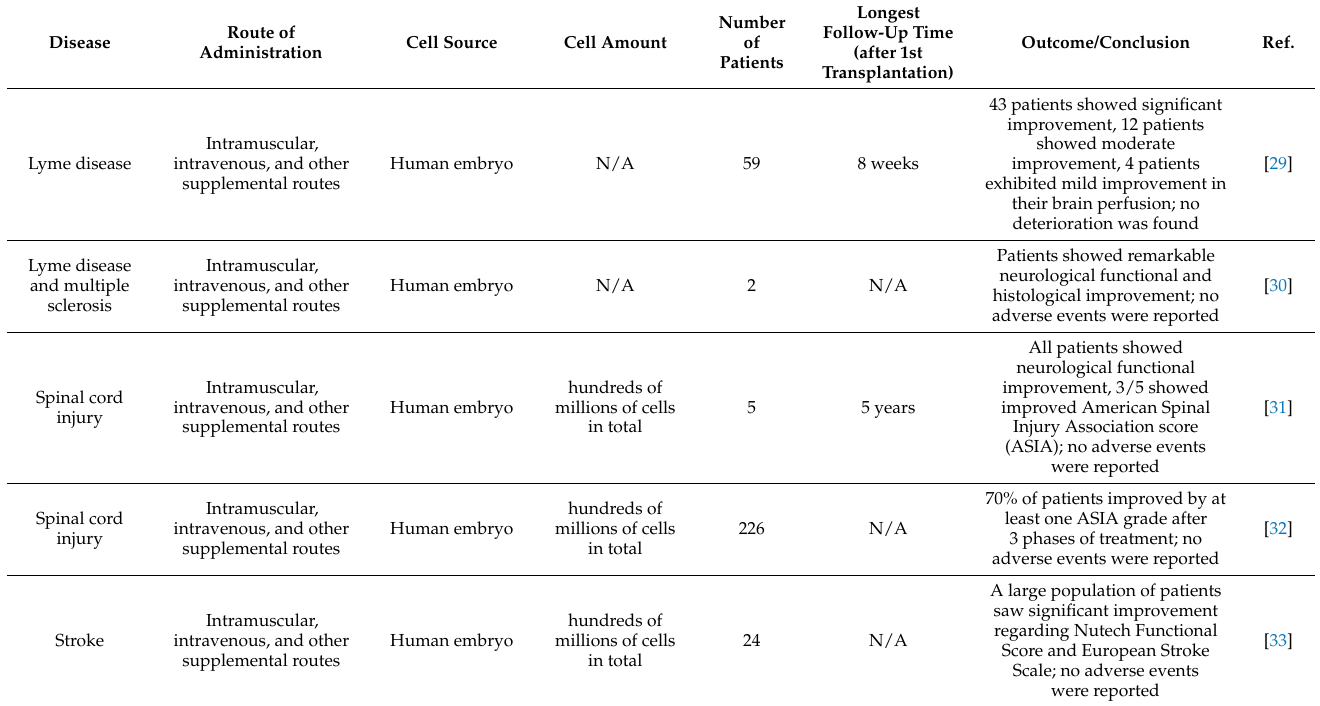
Table 2. Examples of hESC transplantation for neurological disorders in clinical trials (data from PubMed).